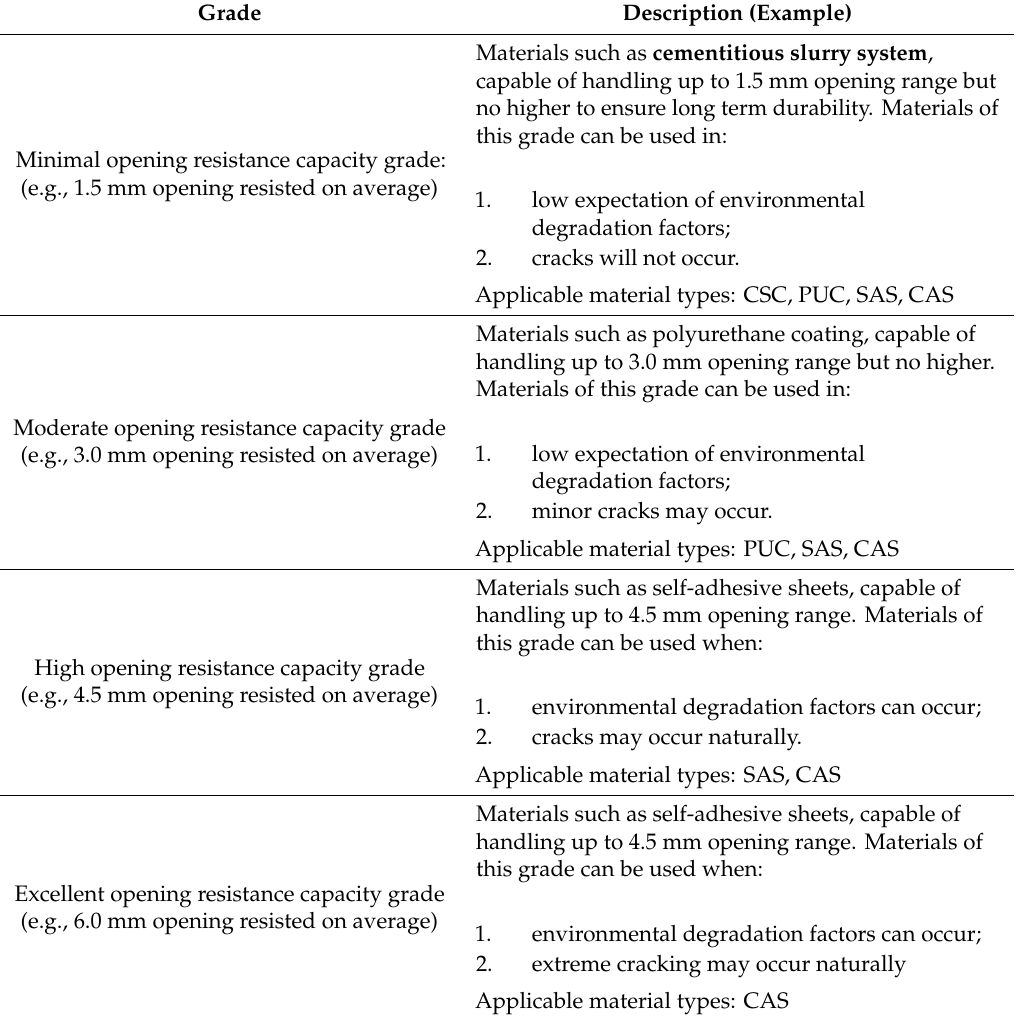
Table 8. Grading criteria